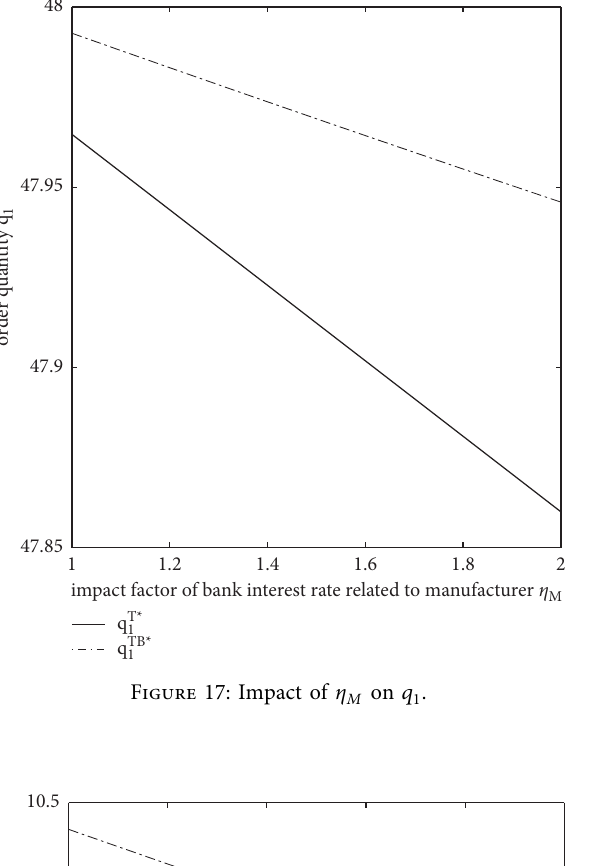
Figure 17: Impact of η